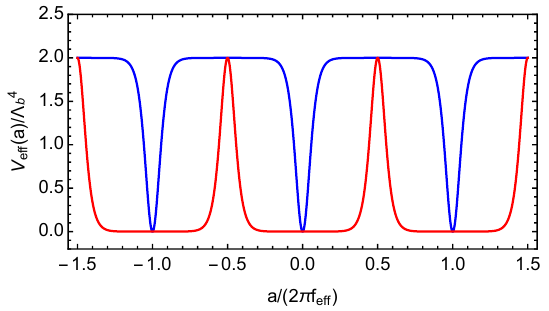
Figure 5 . The axion potentials induced by small parameter deviation at y b = 0 (red) and y b = (cid:25)R (blue). For illustrative purposes, we take a moderated value of m giving mR =